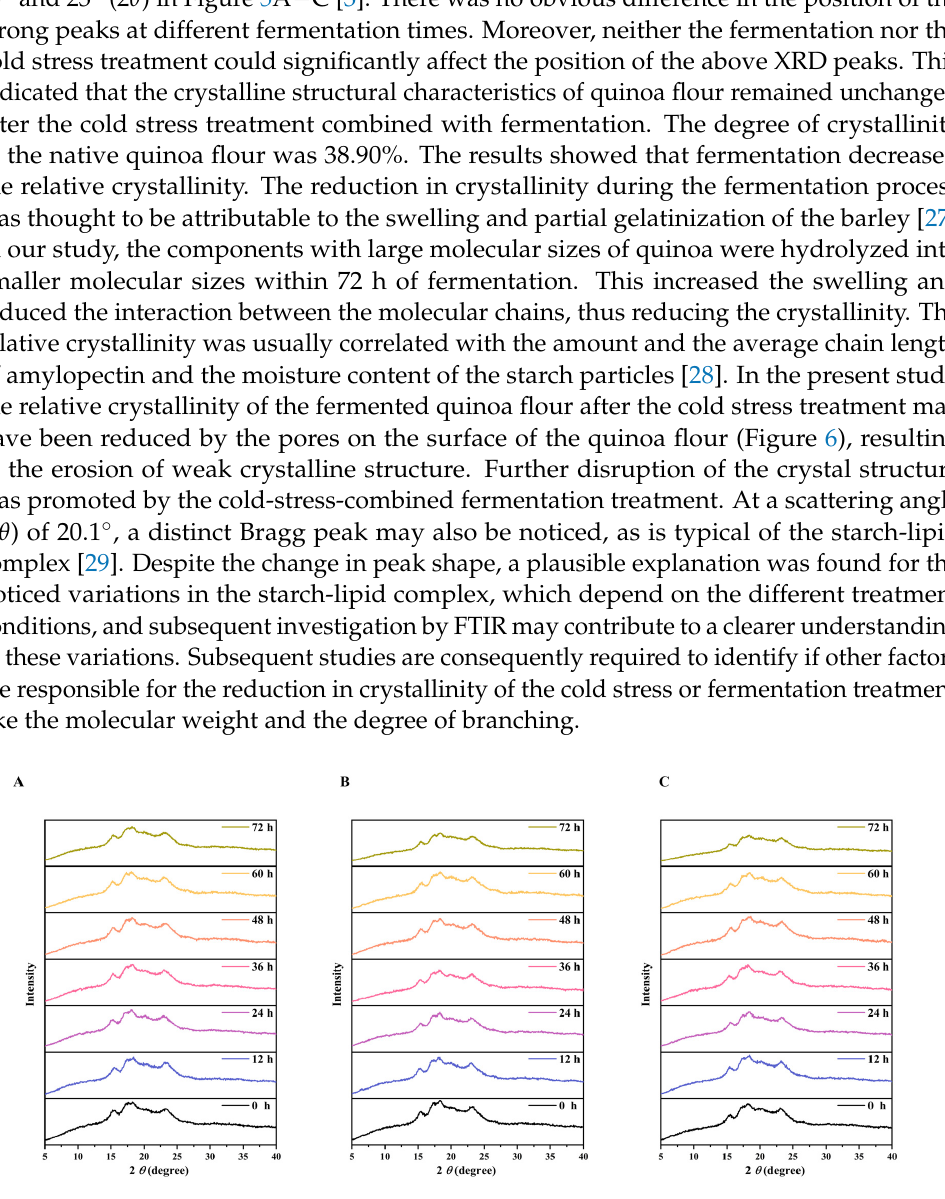
Figure 6. The scanning electron microscopy (SEM) of native and fermented quinoa flour under cold stress at 4 °C and − 20 °C. Native: native quinoa flour; CQ − 4: quinoa flour cold stress treated at 4 °C; CQ − 20: quinoa flour cold stress treated at − 20 °C. The letter A − U represents different samples. 3.6. Changes in Fourier Transform Infrared Spectroscopy (FTIR) The deconvoluted FTIR spectra of the native, CQ − 4 and CQ − 20 samples over 4000 − 500 cm − 1 are listed in Figure 5D − F, and the calculated parameters are listed in Table 1. All FTIR spectra were similar, without the appearance of new peaks, indicating that no functional groups changed under the different treatments of the quinoa. The results showed that the effect of fermentation on the peak levels was limited. However, the peaks decreased sharply after fermentation. The FTIR spectra were compared, and the results